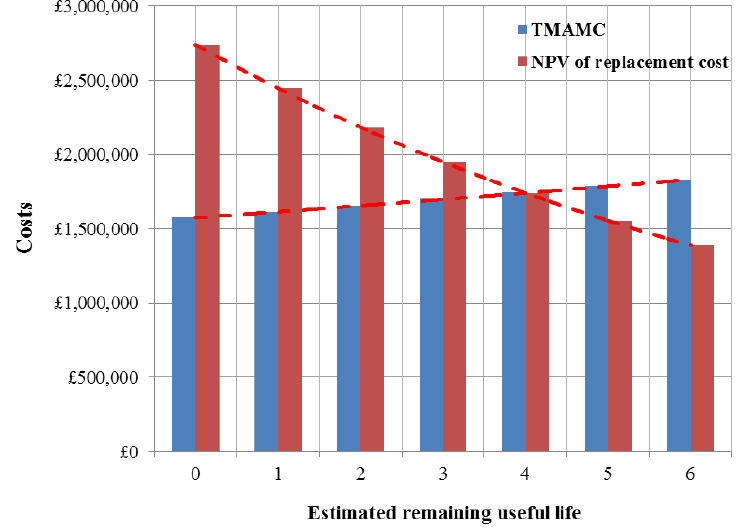
Figure 11. Illustration of optimum replacement period for PT Kembangan.